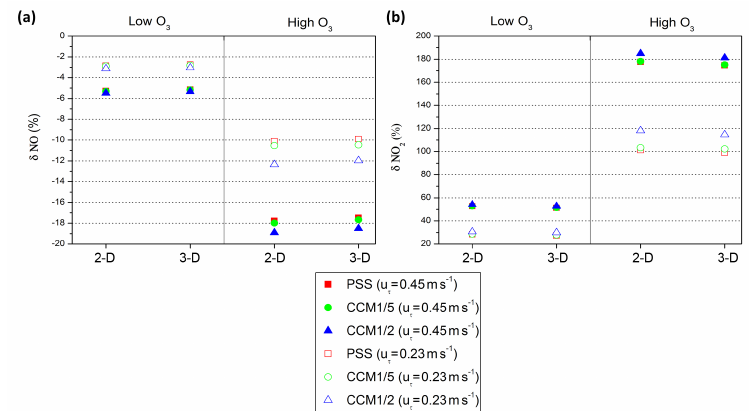
Figure 8. Deviation [NO] N and [NO 2 ] N in average below the canopy top with respect to its corresponding normalized concentration averaged of the tracer in 2-D and 3-D geometry.